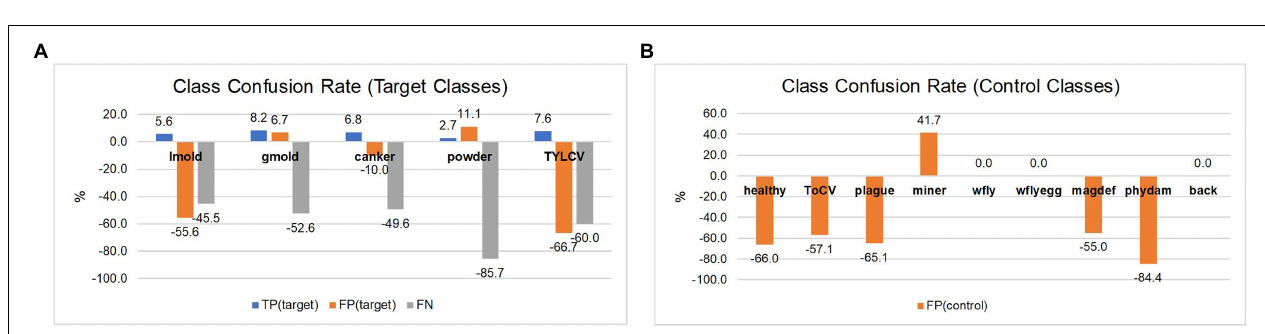
FIGURE 7 | Representation of the tSNE distribution obtained from the model trained without control classes. (A) t-SNE distribution for the whole dataset. (B) Powdery mildew (target class) and its corresponding samples in the features space. (C) Plague (target class) and its samples in the space. Each dot represents a sample, and the colors identify the class assignation. Lines between dots show the connection of each sample to the center of its corresponding class.